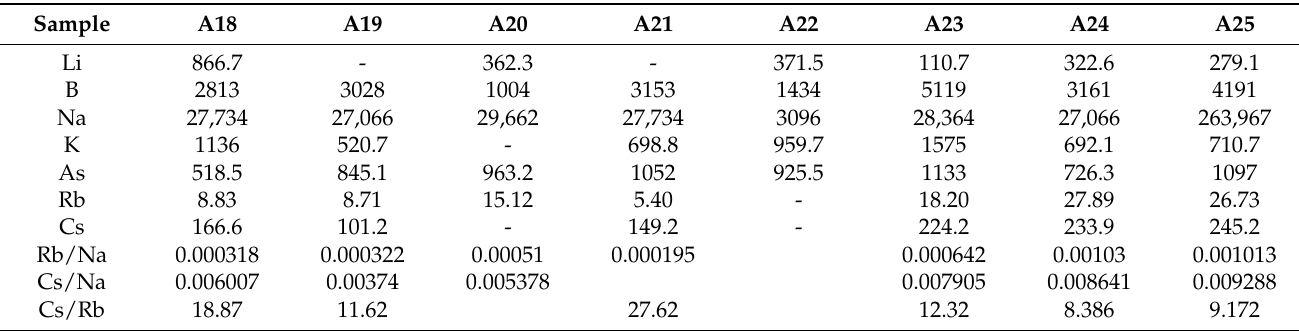
Table 4. LA-ICP-MS in situ analysis of fluid inclusions in quartz of Dakalasu No. 1 pegmatite vein